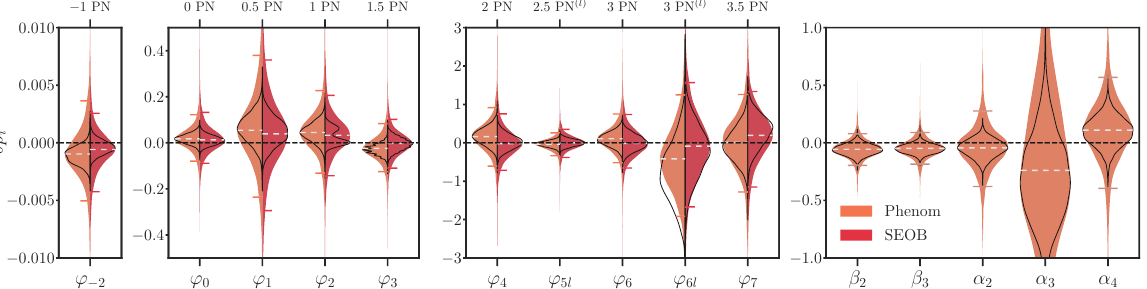
Figure 5. Posterior distributions on the inspiral ϕ i α i , β i and the post-inspiral coefficients considering the detected { } { } BBH population through first, second and (first half of) third observing runs [30]. The filled posteriors are obtained from hierarchical analysis and the unfilled black distributions assuming that all events share a common value for the deviation parameter instead of independently varying it for each event. The results in orange are obtained from the phenomenological waveform model IMRPhenomPv2 , while in red are from SEOBNRv4_ROM waveform model. Error bars represent 90% confidence intervals for the hierarchical results, and the white dashed line denotes the median. The expected GR value, δ p i = 0 is shown by dashed horizontal